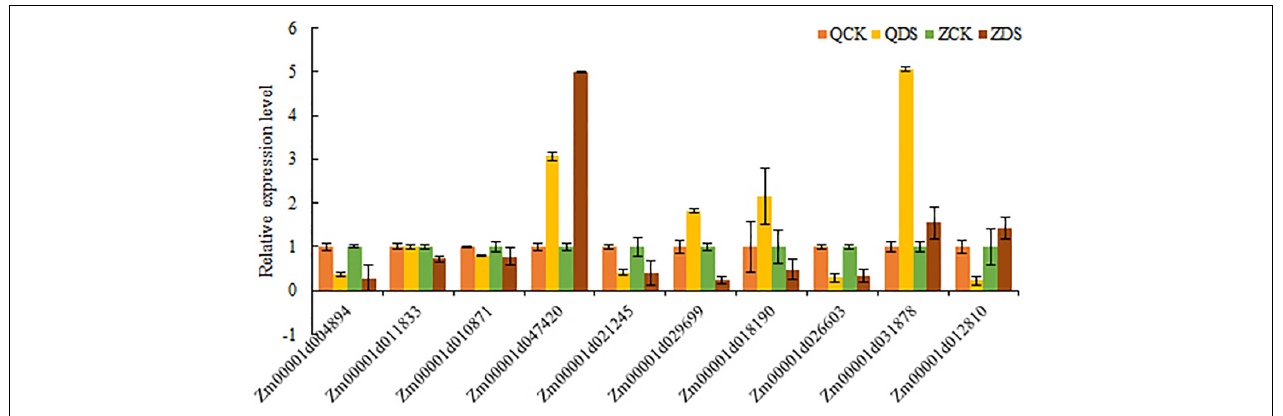
FIGURE 8 | qRT-PCR verification of RNA-seq sequencing